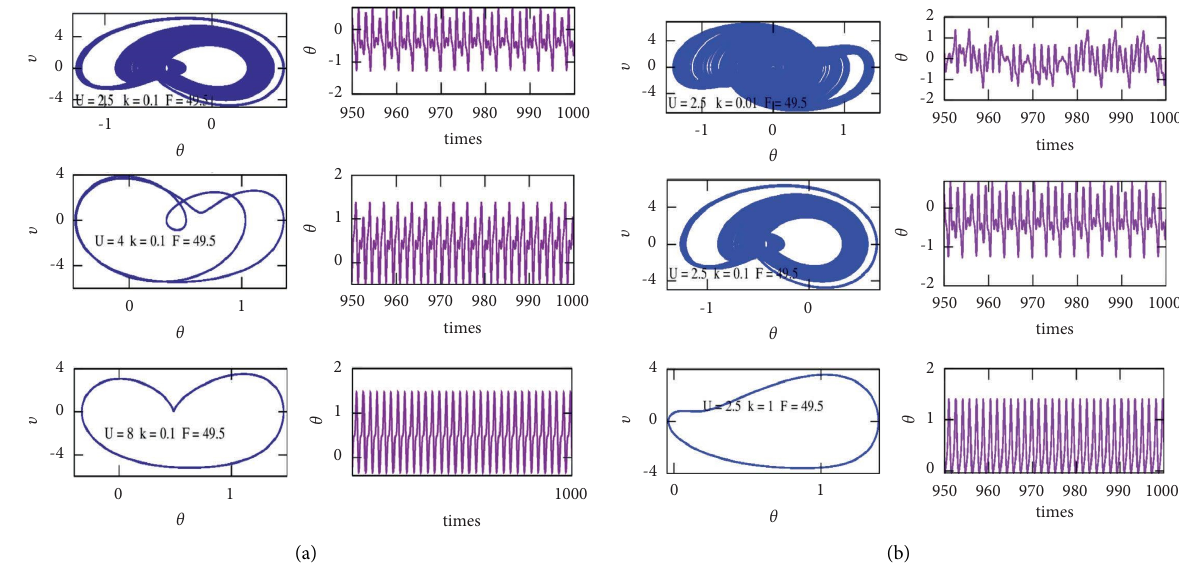
Figure 10: Phase portrait and its time series showing (a) effect of U and (b) effect of K for ϵ � − 1 ; α � 10 ; β � 1 ; Ω � 2 ; C 0 . 05 ; M � 0 . 1 ; g �